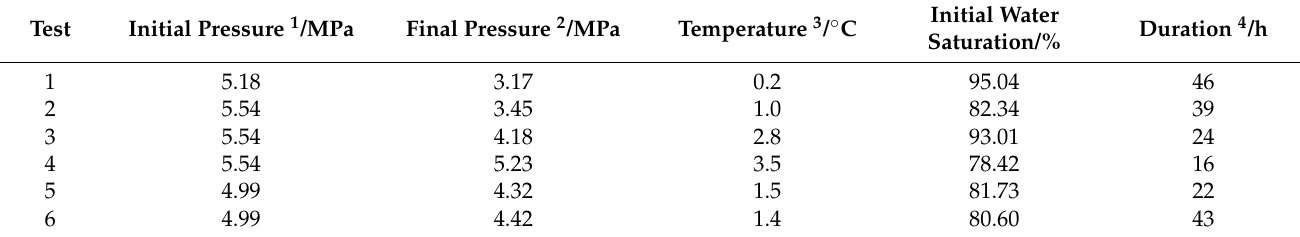
Table 1. Summary of test